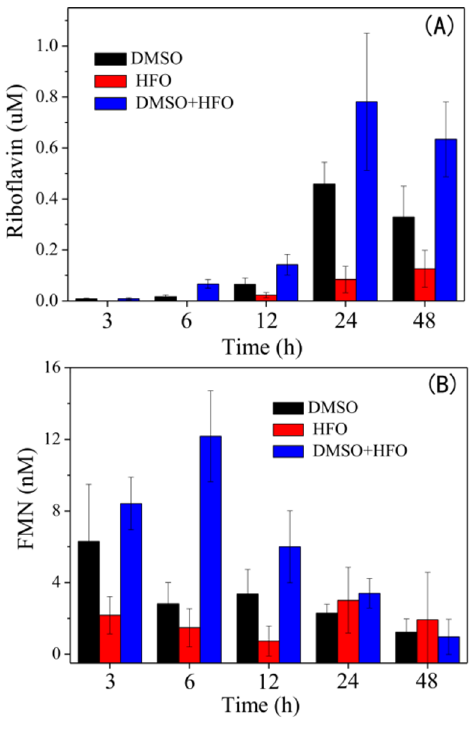
Figure 3. Flavins secretion by S.oneidensis MR-1. Concentration of riboflavin (A) and FMN (B) secreted by S. oneidensis MR-1 in the presence of 20 mM HFO, or 20 mM DMSO or both. The data are the average of triple samples and the error bars represent standard deviation. Concentration of formed Fe(II) through HFO reduction by S. oneidensis MR-1 wild type (WT) was compared with that by the D dmsE mutant (A), and with the dmsB mutant (B).